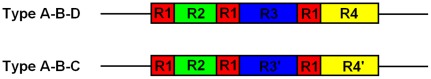
Structure examples: A-B-D and A-B-C types of CagA sequences (not on a proportional scale to sequence length).